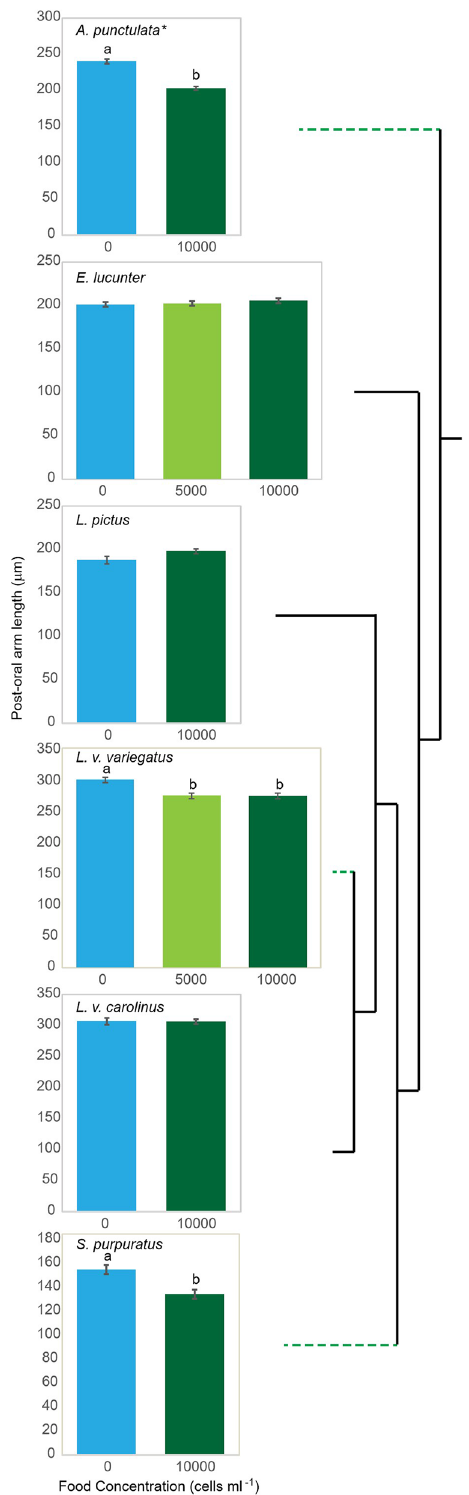
Figure 2. Pre-feeding plasticity has dynamically evolved within the regular urchins. Change in post-oral arm length at initiation of feeding averaged across families with food concentration in Echinacea, the regular urchins. *Data from a single family of A. punctulata is presented for clarity, though food treatment was significant across all families tested (Table 2). Phylogenetic tree is not scaled to divergence. Green dotted lines denote taxa with canonical pre-feeding plasticity. Error bars, ± standard error of the mean. Letters denote a significant difference between food treatments at p < 0.05 (Table